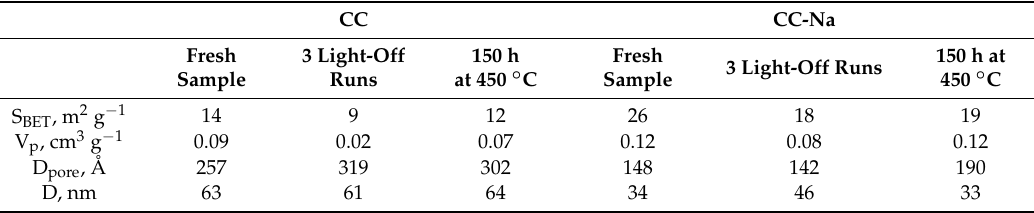
Table 4. Comparison of textural/structural properties between fresh and used